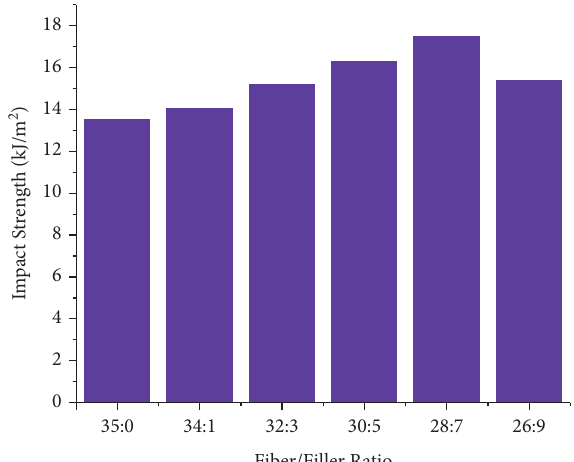
Figure 11: Effect of fibre/filler loading on impact strength for epoxy resin/madar fibre/sugarcane bagasse ash composites.